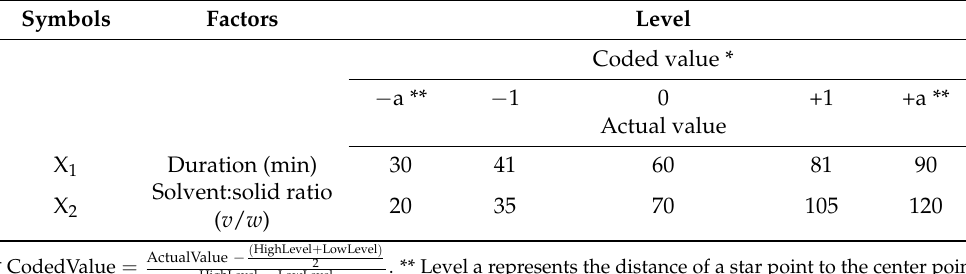
Table 2. Levels of independent variables in actual and coded